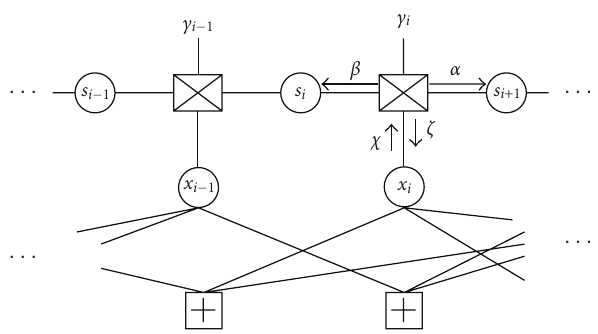
Figure 5: Joint factor graph for decoding and channel state estimation of an LDPC-BC on a Markov channel